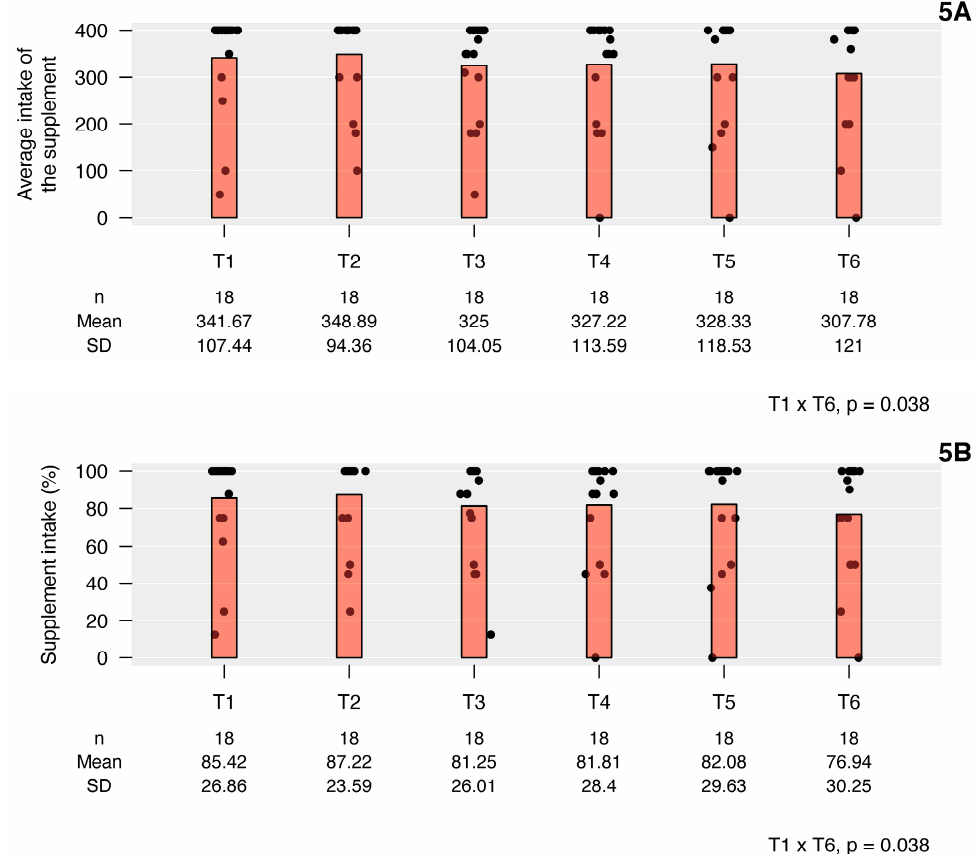
Figure 5. Intake (mL) and acceptance (%) of the supplement during the 6 months of study. p : longitu- dinal mixed effects linear model. ( 5A ) average intake of the supplement vs. time; ( 5B ) supplement intake (%) vs. time.